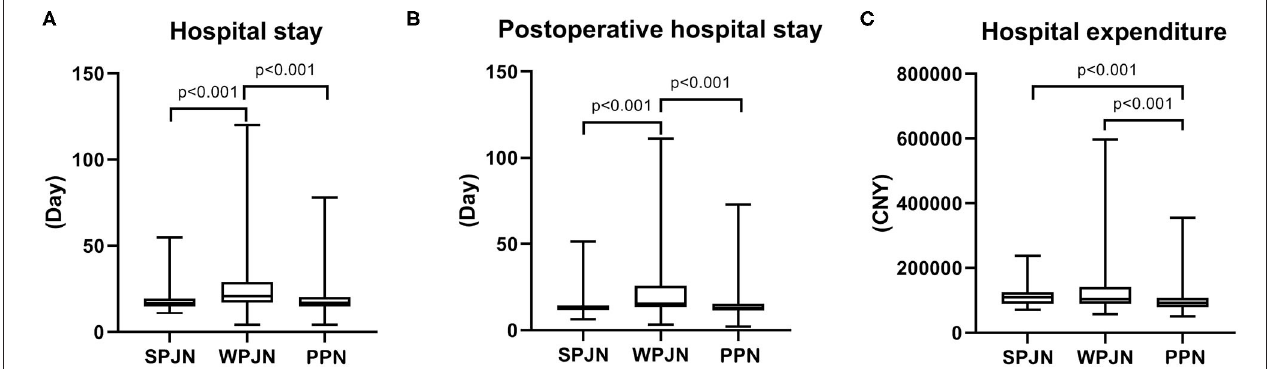
FIGURE 6 | Economic benefits. Hospital stay and post-operative hospital stay in the SPJN group were remarkably shorter than those in the WPJN group, and they were significantly shortened in the PPN group compared with those in the WPJN group (A,B) . Moreover, patients in the PPN group spent significantly less money on hospitalization than those in the SPJN group and the WPJN group (C)